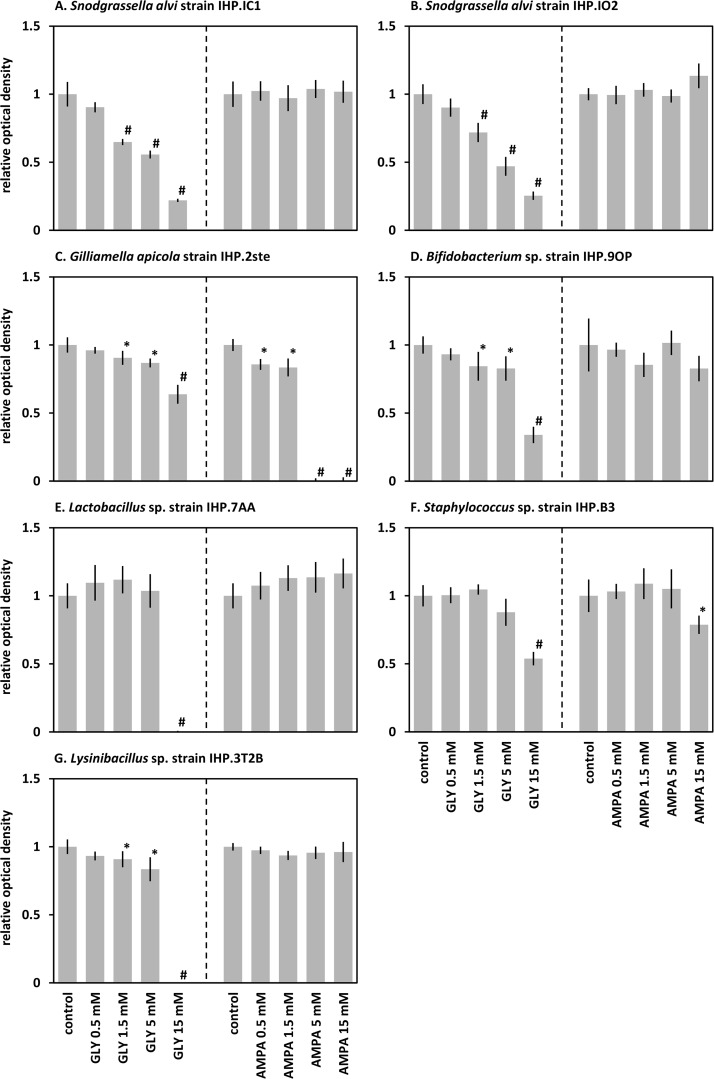
Growth of bacterial strains isolated from the honeybee gut in the presence of glyphosate and AMPA.Strains were inoculated in HIB or MRS medium in the presence of increasing concentrations of glyphosate (GLY) or AMPA. After 48h of growth under anaerobic conditions, the optical density of the cultures was measured at 600 nm. The results are presented as the mean ratio between treated culture and control culture without xenobiotic that was used as a calibrator. Data were gathered from six independent replicates. Bars represent the 95% confidence intervals. A significant difference (Student t-test or Mann-Whitney test) is indicated by a star (p<0.05) or a hash mark (p<0.001).